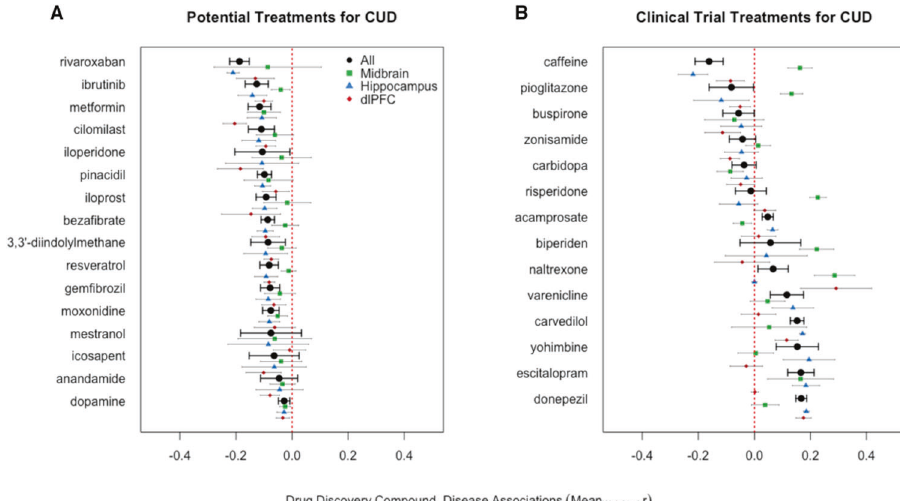
Fig. 2 Drug-discovery results for CUD using human brain data. Panel ( A ) shows repurposable compounds negatively associated with CUD gene expression in the brain (all p adj < 0.05). Panel ( B ) shows the results of the medications currently undergoing clinical trials for CUD. The x - axis represents the weighted average of a compound ’ s correlation coef fi cients with the human brain CUD genes and each compound ’ s weighted standard error bars. Also, note that the black circles represent the effect across all brain regions/studies and the points below are color coded by brain